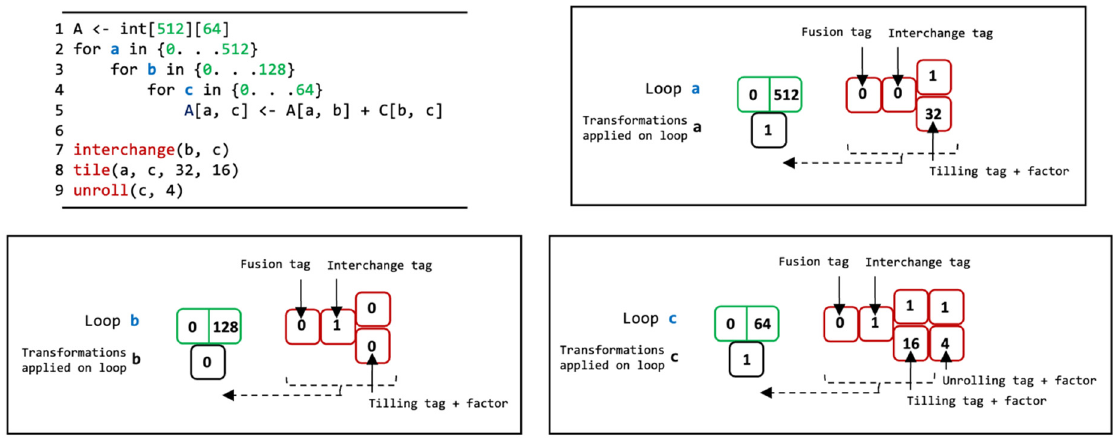
Figure 9. Loop optimization representation and pseudocode.